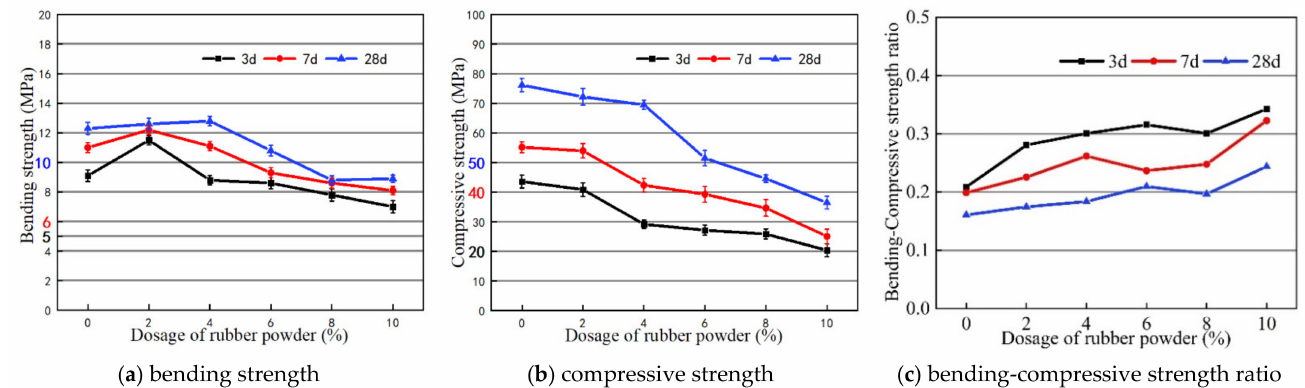
Figure 4. Mechanical strength of PPG with untreated 30 mesh of crumb rubber at different